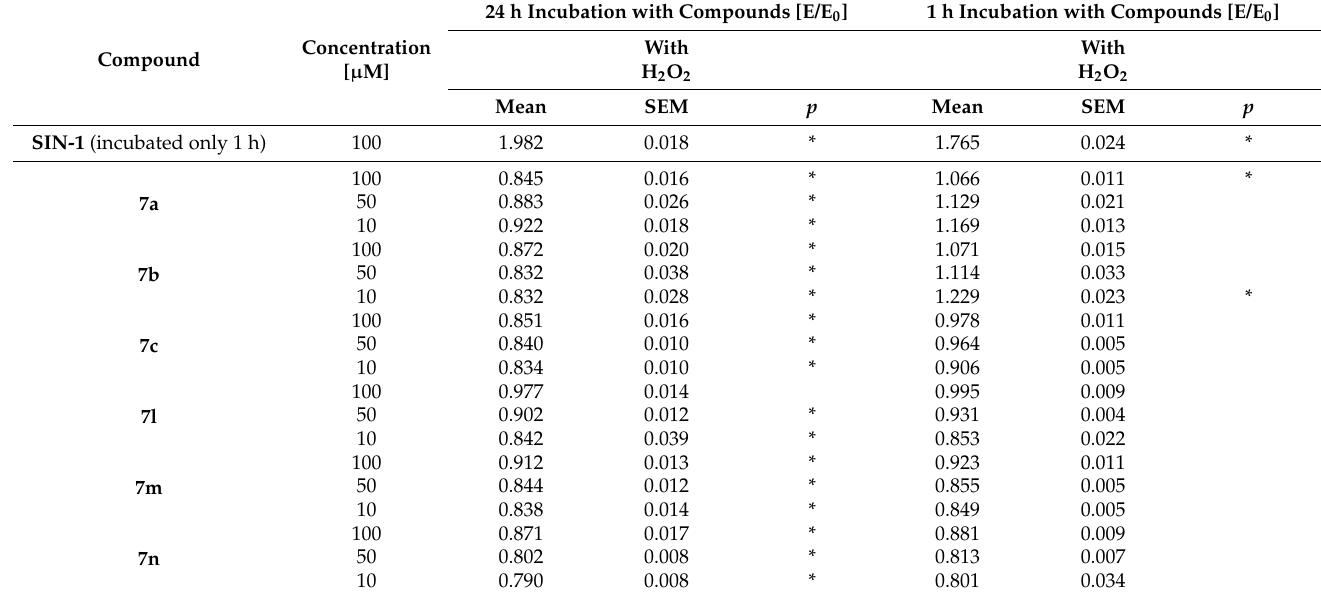
Table 5. RNS scavenging activity of compounds [mean (SD); n = 5]; the results were compared to the control and expressed as E/E0 ratios; statistical significance calculated with post hoc test compared to the control (* p < 0,05; E0—cultures without tested